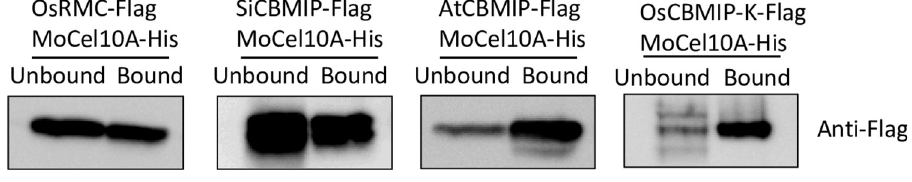
Fig 7. CBM1-binding proteins are widespread in plants. CRRSPs (OsRMC, SiCBMIP, and AtCBMIP) and OsCBMIP-K bind MoCel10A. Flag-tagged CRRSPs and OsCBMIP-K were incubated with MoCel10A-His in the presence of His-resin. Fractions unbound and bound to His-resin were subjected to immunoblot analysis using an anti-Flag antibody.